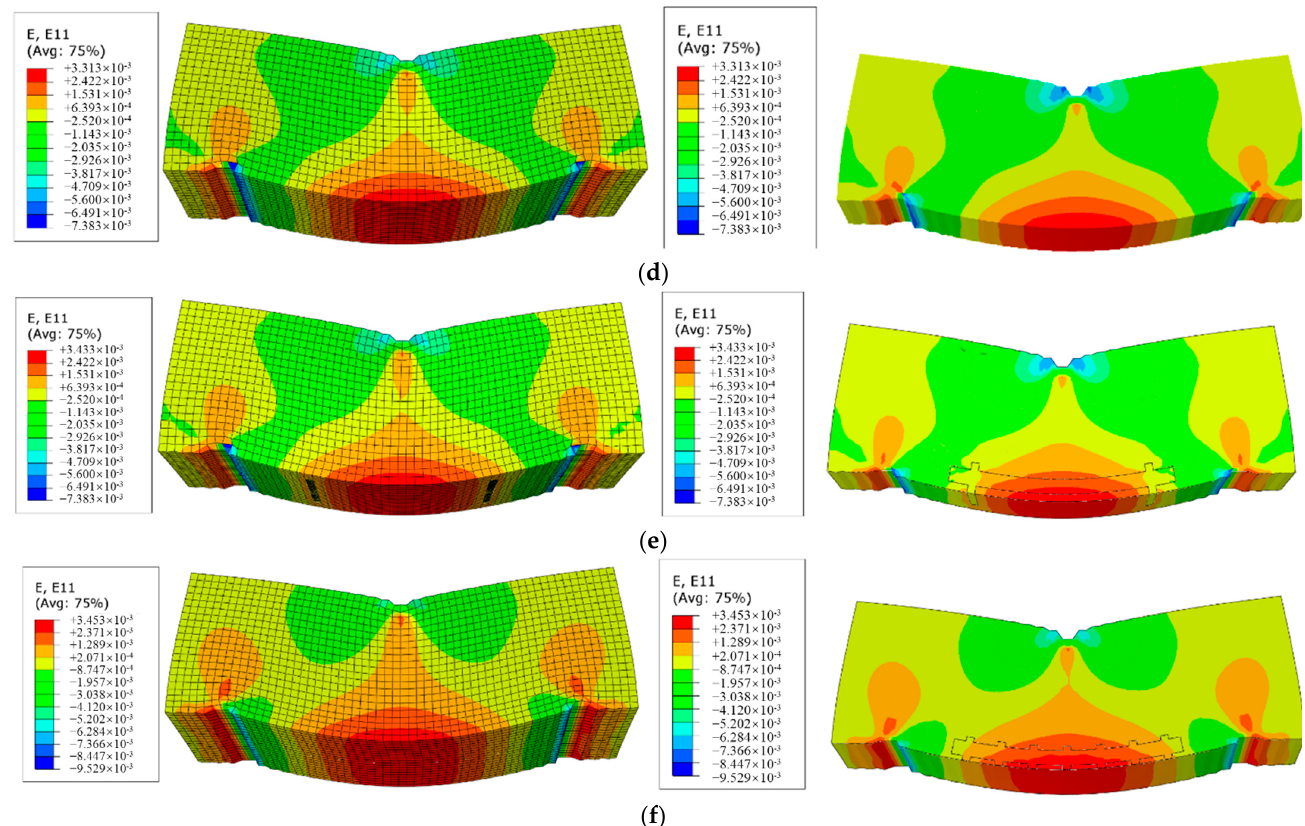
Figure 3. S11 and E11 of asphalt beam under static progressive loading condition, ( a ) S11 without embedded sensors, ( b ) S11 with I-shaped sensor, ( c ) S11 with corrugated-shape sensor, ( d ) E11 without embedded sensors, ( e ) E11 with I-shaped sensor and ( f ) E11 with corrugated-shape sensor.